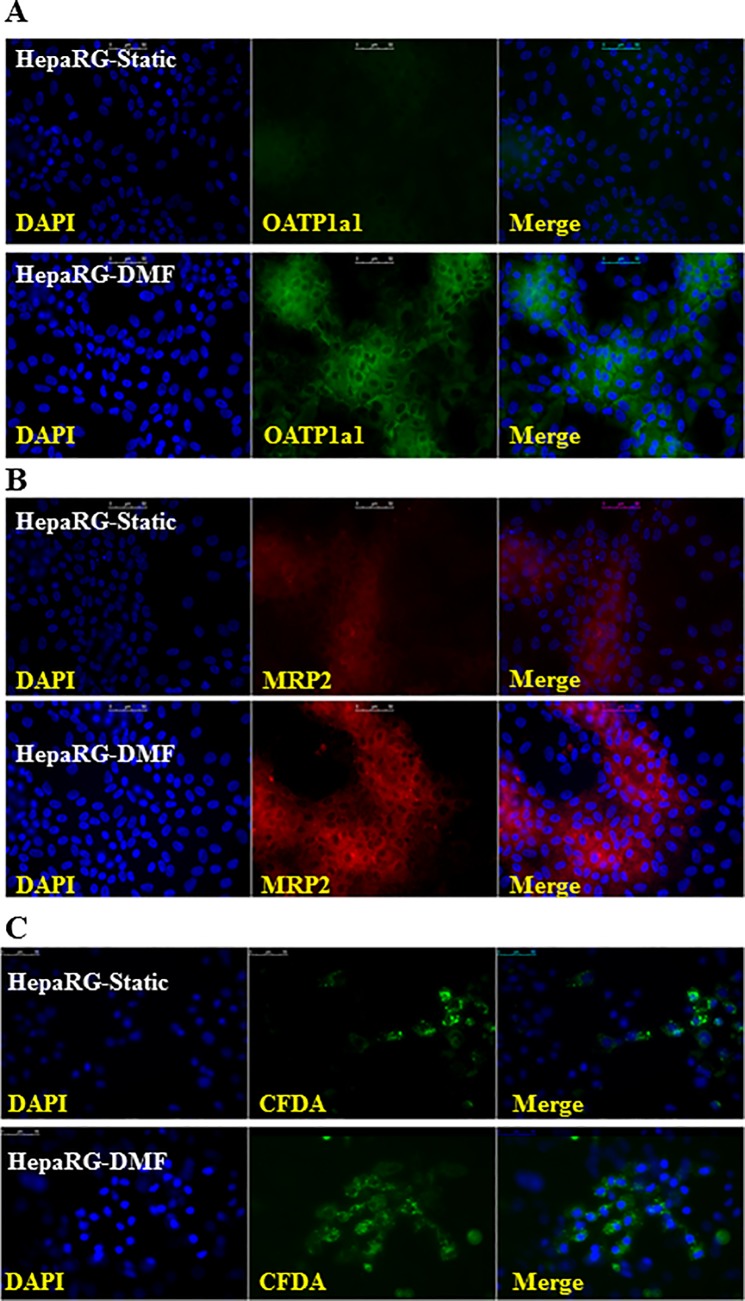
DMF-culturing does not improve the polarization of the HepaRG cells.(A-B) Staining of hepatic transporters OATP1a1(green) and MRP2 (red) with DAPI counter-staining for the nuclei (blue). (C) Visualization of CFDA (green) with DAPI counter-staining of the nuclei (blue), scale bar = 50μm.